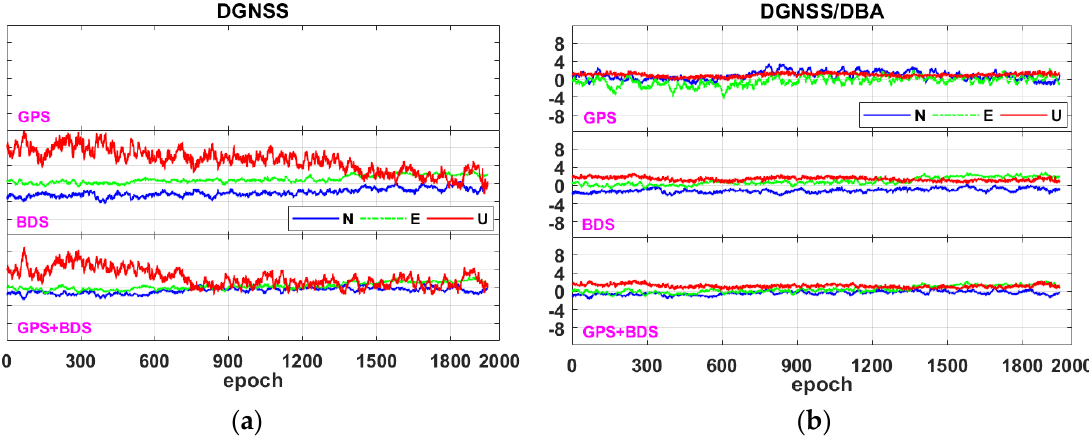
Figure 8. The deviation sequence diagram in the N/E/U directions at 40 − degree elevation mask an-